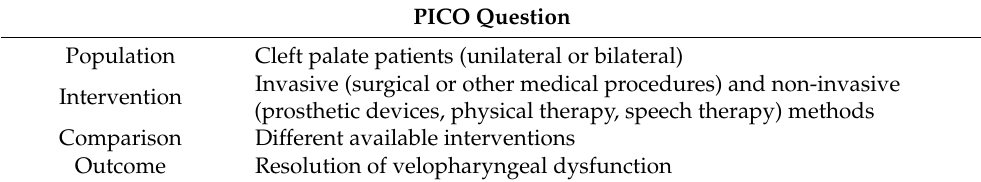
Table 1. PICO question.